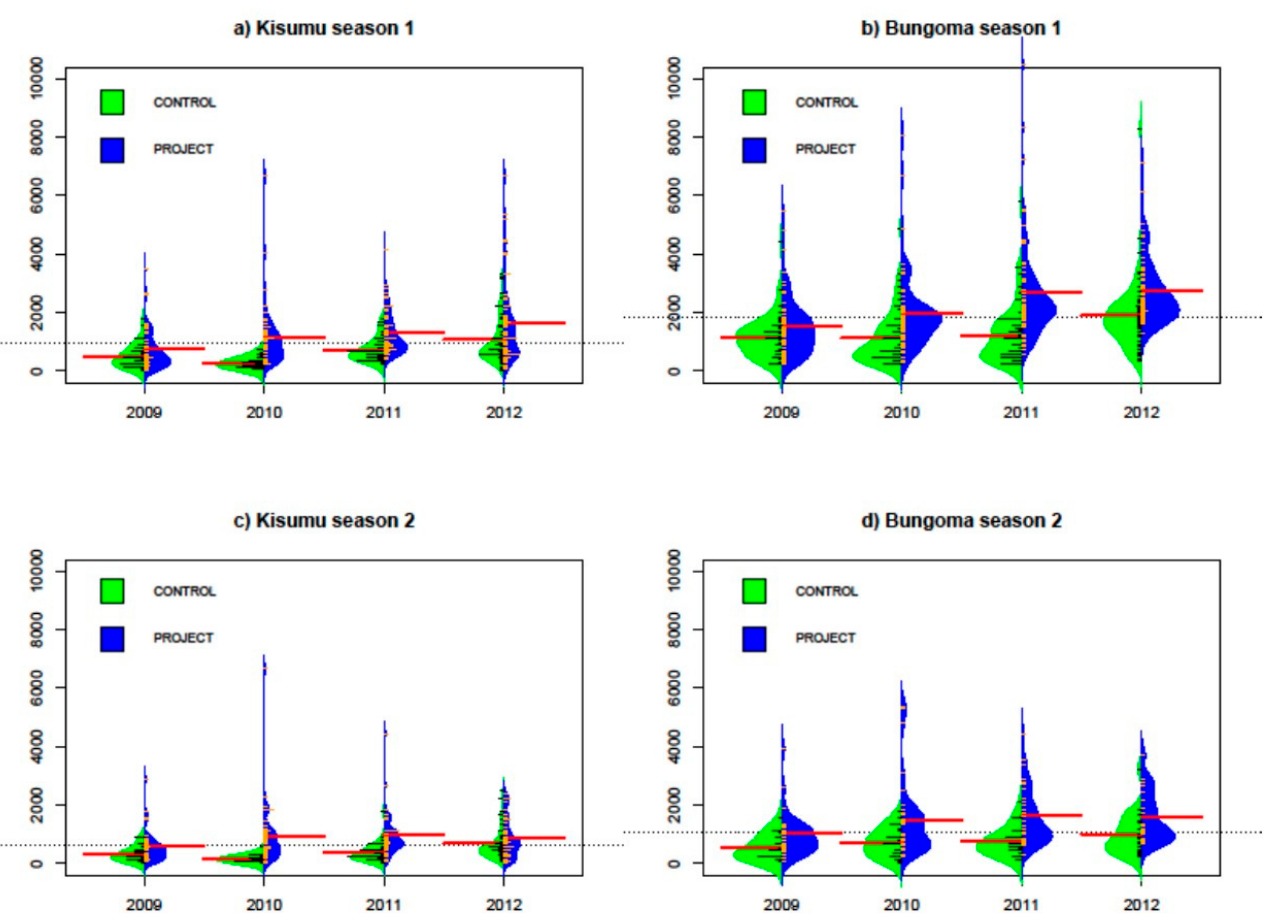
Figure 5. First-season ( a , b ) and second-season ( c , d ) maize yield kg ha − 1 on project (blue) and control (green) farms in Kisumu ( a , c ) and Bungoma ( b , d ), 2009–2012. The lines indicate mean values for each distribution and the dotted line shows the mean for each sub-plot.